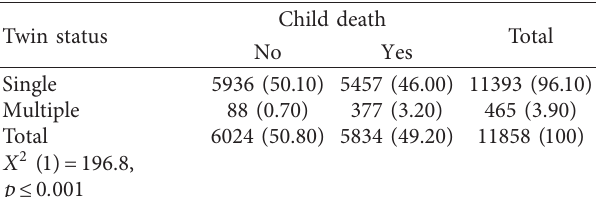
Table 4: Presence of twin child on child